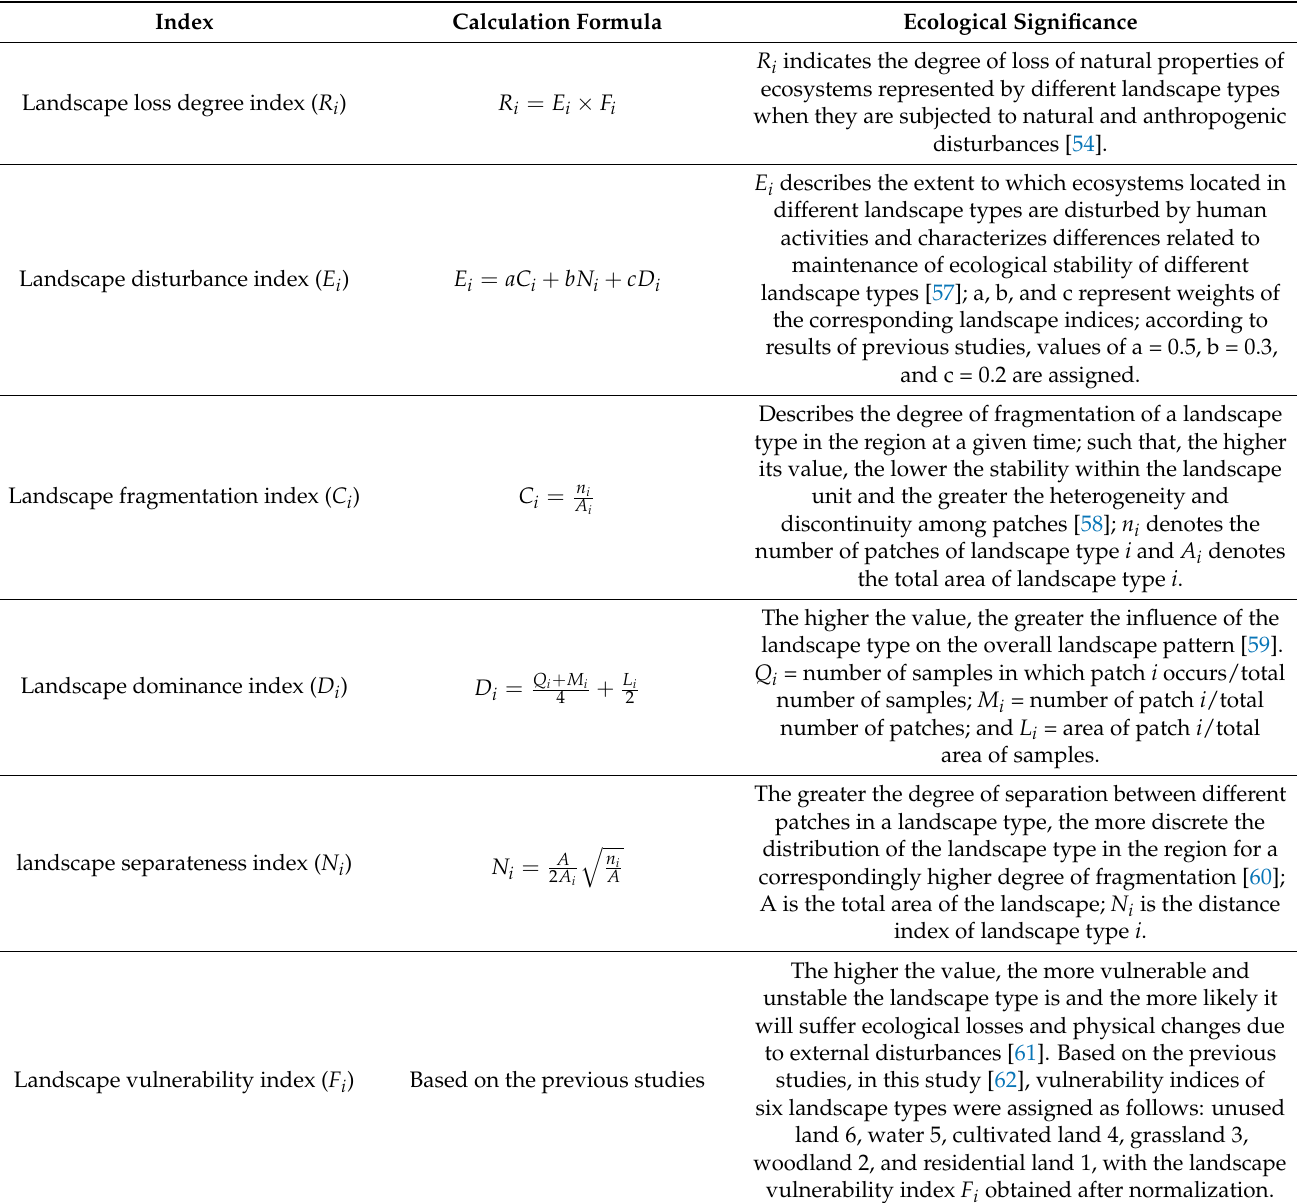
Table 1. Calculation formula of landscape index and ecological